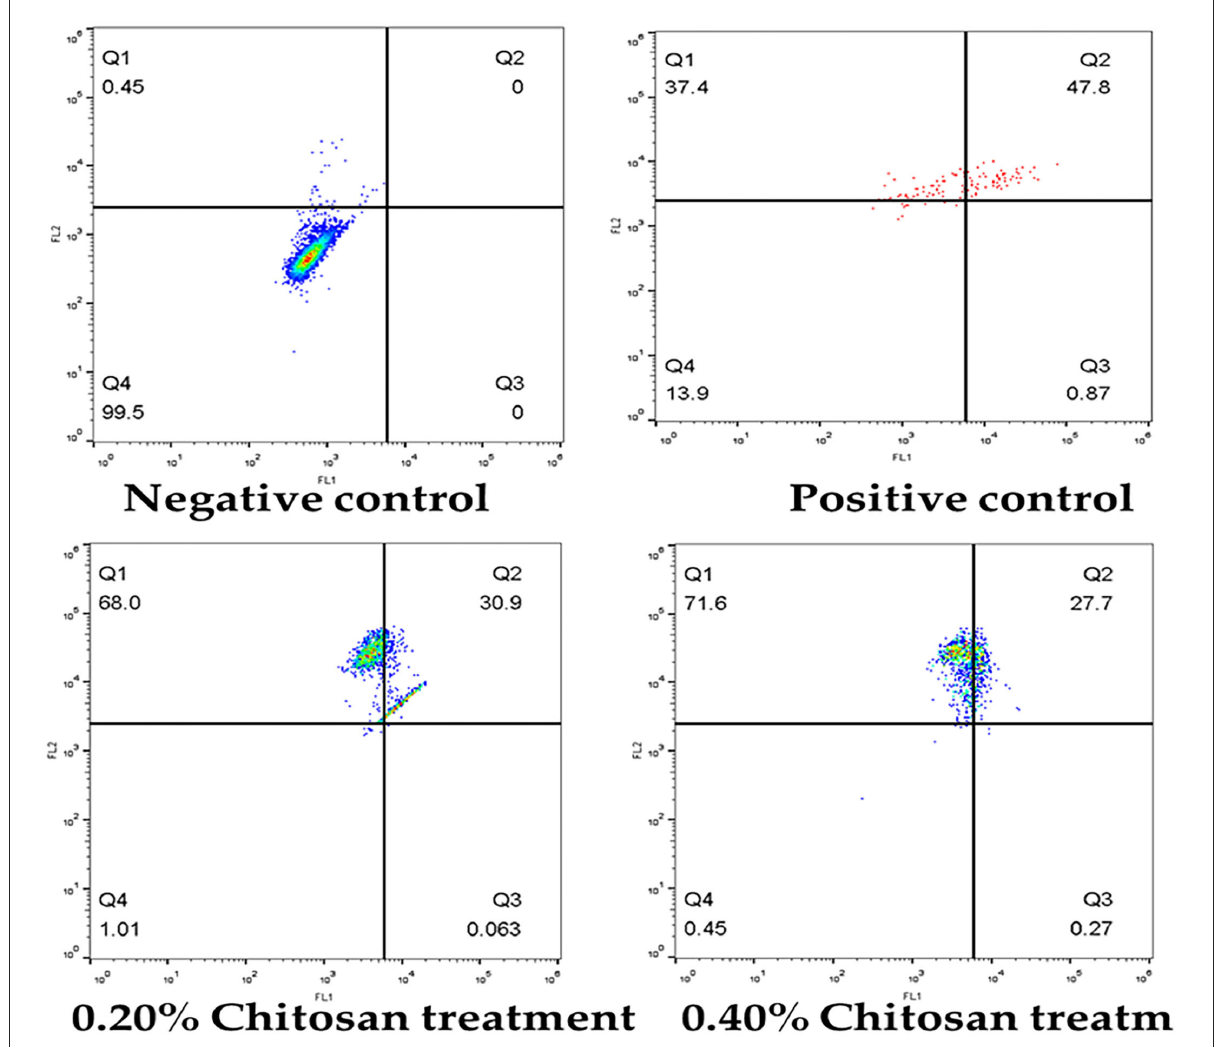
FIGURE7 Flow cytometric analysis of apoptosis induction in HeLa cells treated with different concentrations of chitosan.